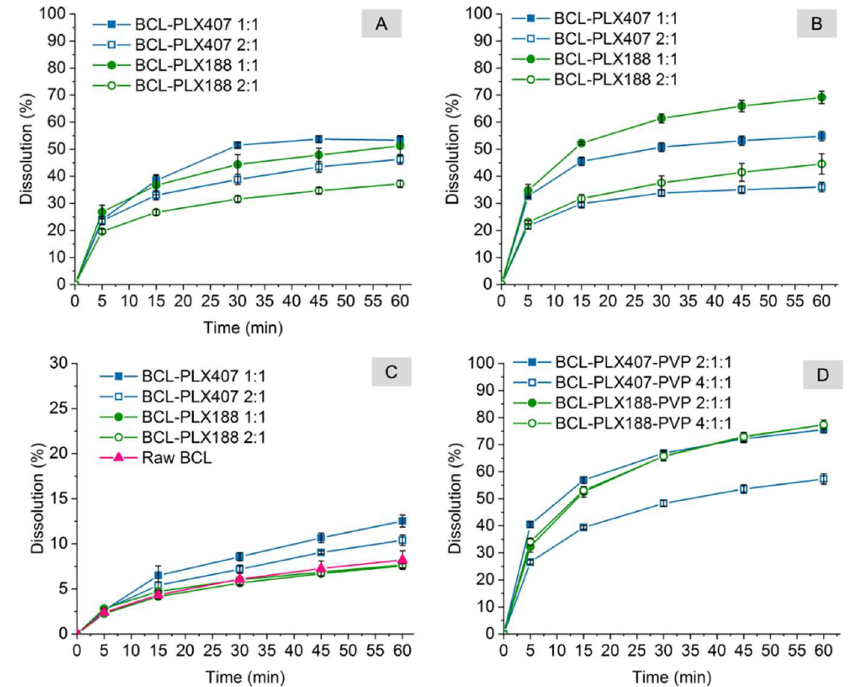
Figure 13. Dissolution of binary and ternary systems containing bicalutamide, poloxamers and PVP (in case of ternary systems) obtained using the evaporation technique ( A ), spray drying ( B and D ), and physical mixing ( C ).